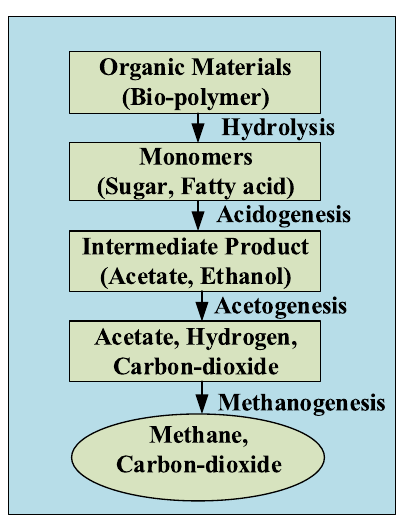
Fig. 7 Flow Chart of Methanogenesis Process